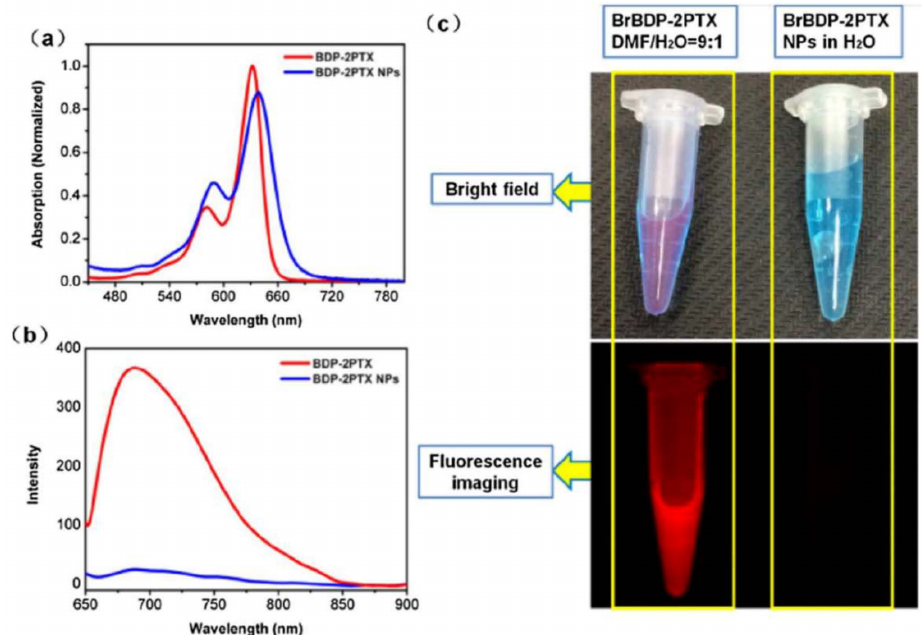
Figure 5. UV–Vis absorption ( a ) and fluorescence ( b ) spectra of nanoparticles 20 (NPs) in aqueous solution and free 20 in DMF/H 2 O 9:1. ( c ) Fluorescent photos 20 and NPs 20 in water and in DMF/H 2 O 9:1. Adapted from